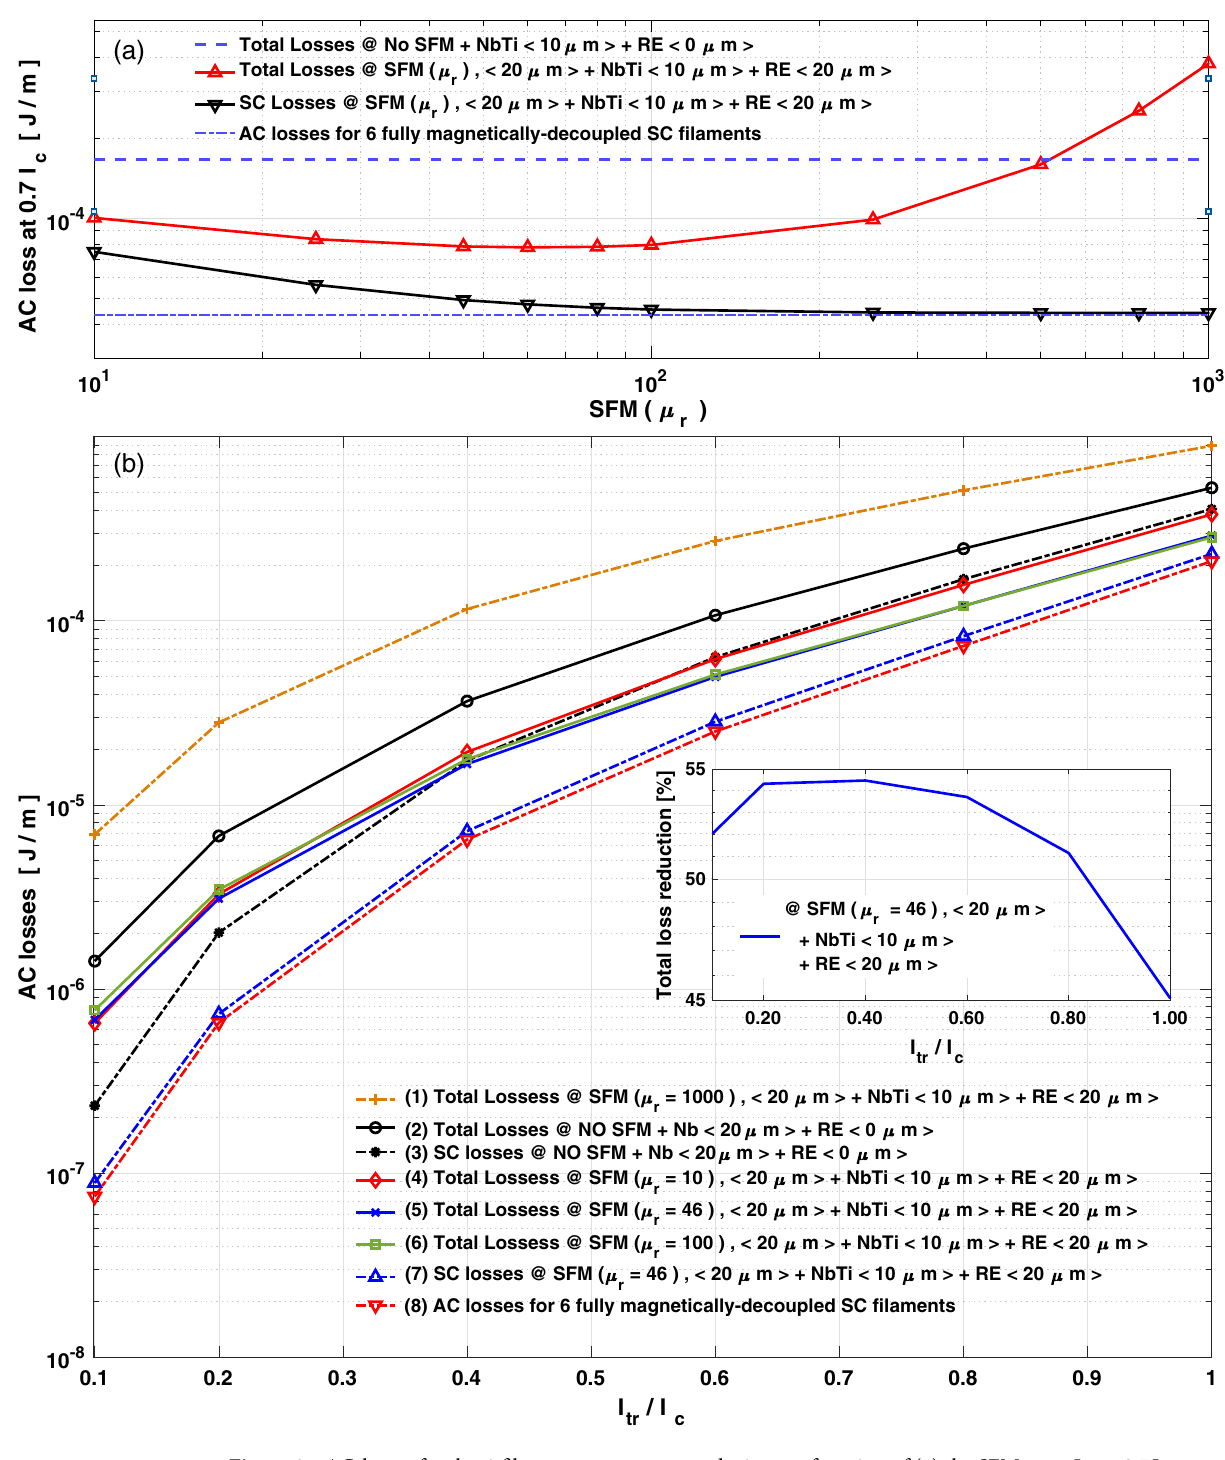
Figure 3. AC-losses for the 6-filaments metastructured wire as a function of ( a ) the SFM µ r at I tr = 0.7 I c , and ( b ) the I tr condition with different SFM µ r options (curves 1–6), leading to the optimal design (5), where a nearly perfect magnetic decoupling between SC filaments is shown (7–8). The inset shows the total AC-loss reduction for the optimal